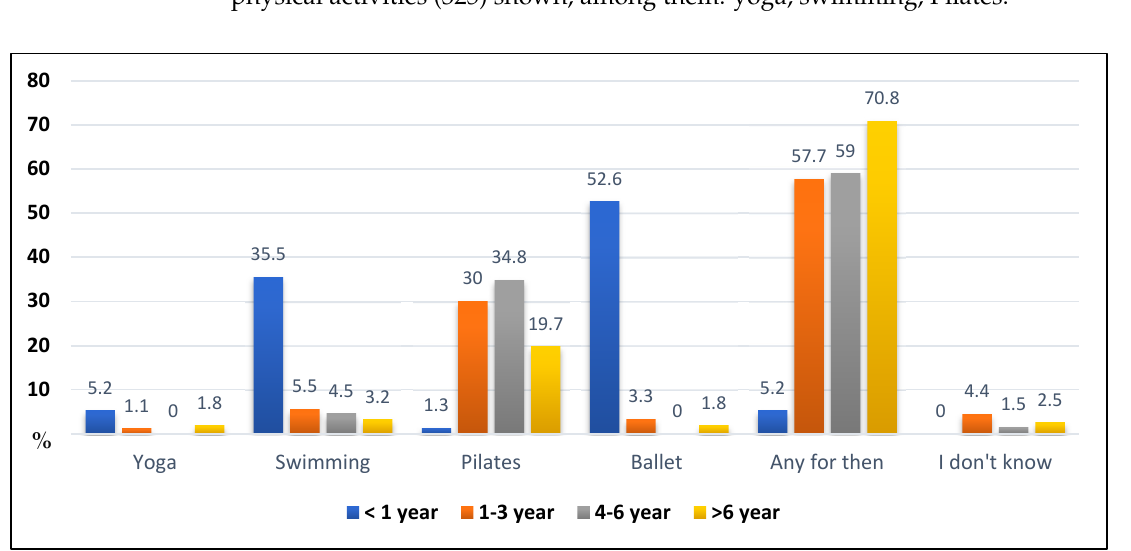
Figure 2. Percentual of participants opinion on the conservative method that would be recom- mended for the treatment of AIS.